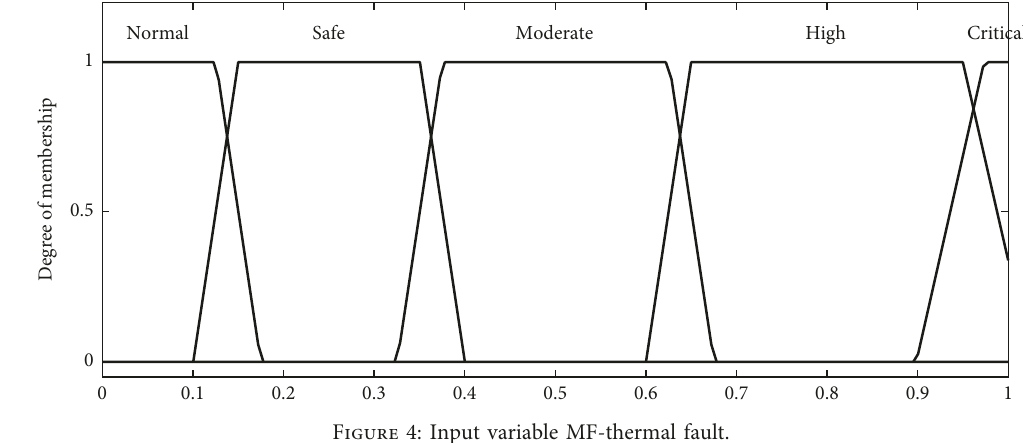
Figure 4: Input variable MF-thermal fault.